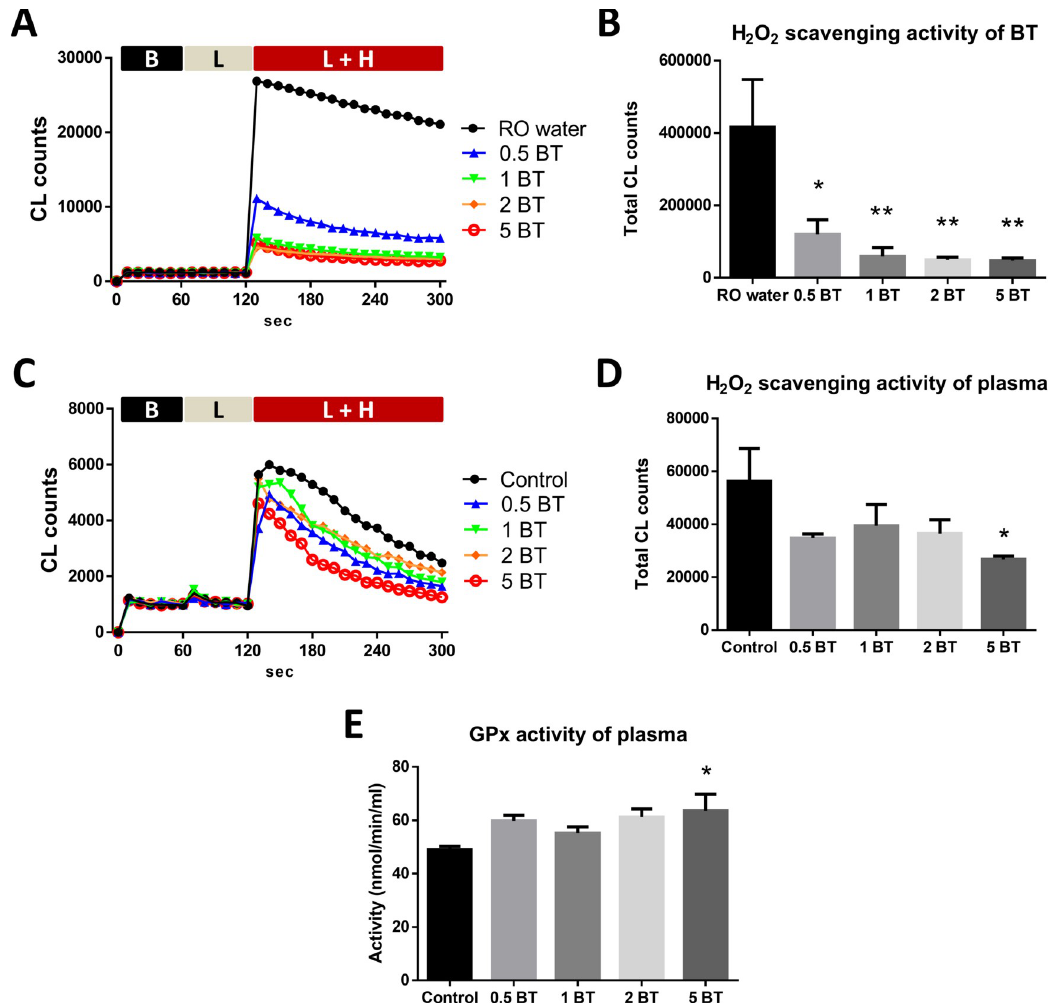
Fig 2. Antioxidant activity of BT and plasma. (A) The curves of CL counts in several kinds of water. B, baseline; L, luminal; H, H 2 O 2 . (B) H 2 O 2 scavenging activity of BT. H 2 O 2 scavenging activity was indicated by CL counts in several kinds of water. CL counts were decreased by 0.5 BT, 1 BT, 2 BT and 5 BT (n = 3). RO, reverse osmosis. (C) The curves of CL counts in plasma of different groups. B, baseline; L, luminal; H, H 2 O 2 . (D) H 2 O 2 scavenging activity of plasma. CL counts were decreased by plasma of 5 BT drinking group (n = 3). (E) Glutathione peroxidase activity of plasma. The plasma from 5 BT drinking group demonstrated increased glutathione peroxidase activity (n = 3). GPx, glutathione peroxidase. The data are mean ± SEM and analyzed by one-way ANOVA. � P < 0.05; �� P <